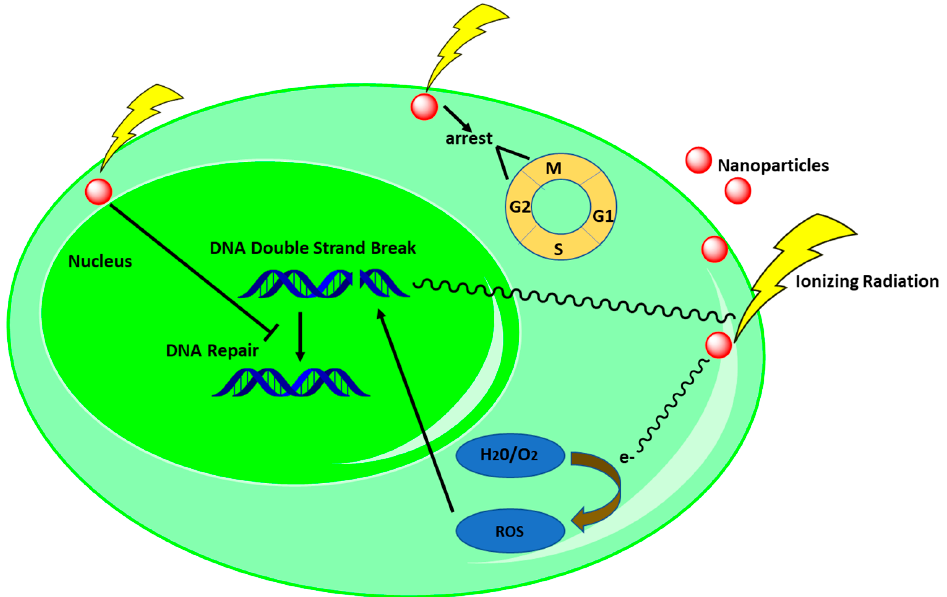
Figure 2. Biological responses of NPs aiding RT. Ionizing radiation causes direct damage to DNA, which is repaired by the cells’ own repair mechanism. However, NPs with RT interfere with the DNA-repair process, leading to cancer cell death. Moreover, ionization induces ROS generation, which damage DNA-killing cancer cells. In addition, radiation together with NPs arrests the G2/M phase of the cell cycle and results in cancer cells death